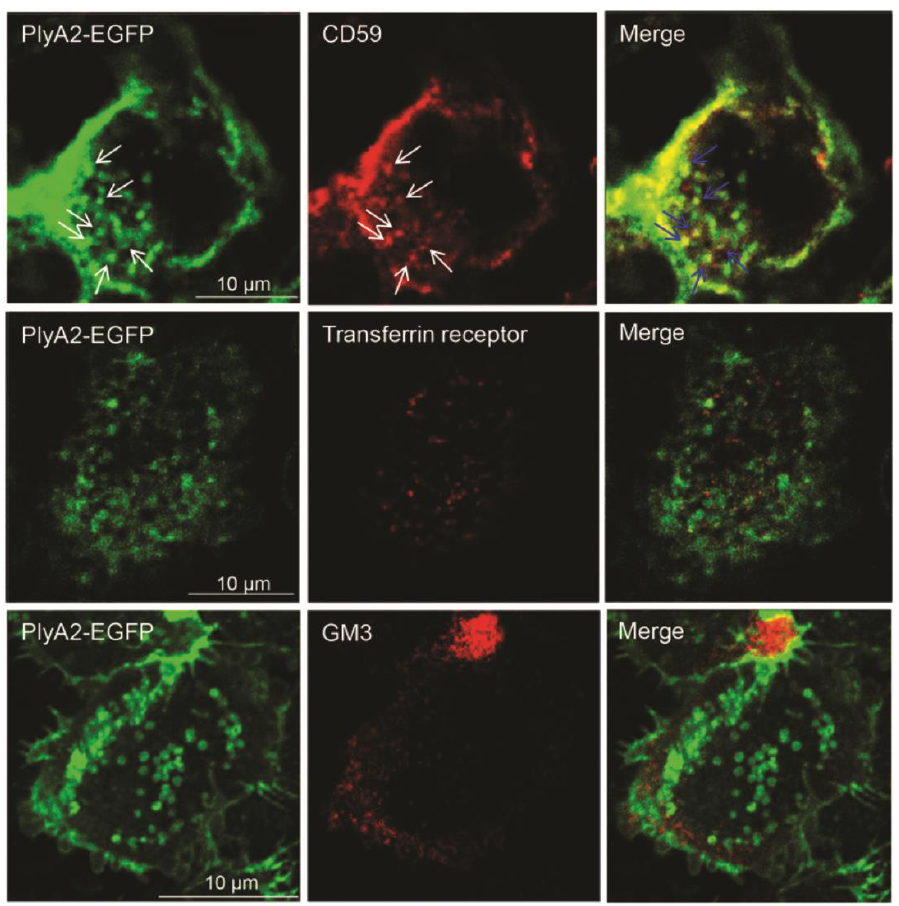
Figure 3. Cell surface distribution of PlyA2-EGFP (green) and lipid raft markers (red). Fixed HeLa cells were doubly immunolabeled with PlyA2-EGFP and antibodies against raft-associated glycosylphosphatidylinositol-anchored protein CD59 and ganglioside GM3. Alternatively, cells were labelled with non-raft transferrin followed by fixation and PlyA2-EGFP labelling. Arrows, partial co-localization between PlyA2-EGFP and CD59. Based on dot-by-dot comparisons, about 45% of CD59-positive dots co-localized with PlyA2-EGFP. In contrast, only 5% of the non-raft transferrin receptor was visualized with plasma-membrane-bound Alexa-labelled transferrin. Ganglioside GM3 did not show significant co-localization with SM/Chol domains labeled by PlyA2-EGFP. Adapted from [38].